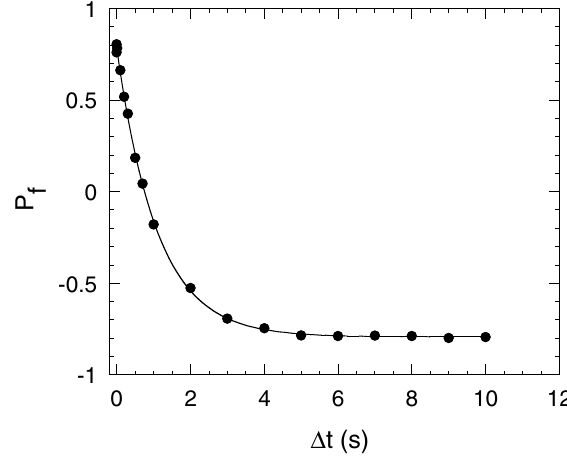
FIG. 3. The measured proton polarization at 1 : 941 GeV =c is plotted against the rf-dipole ramp time (cid:15) t . The rf-dipole’s frequency half range (cid:15) f= 2 was 5 kHz, and its R B dl rms 0.11 T mm. The curve is a fit using Eq.